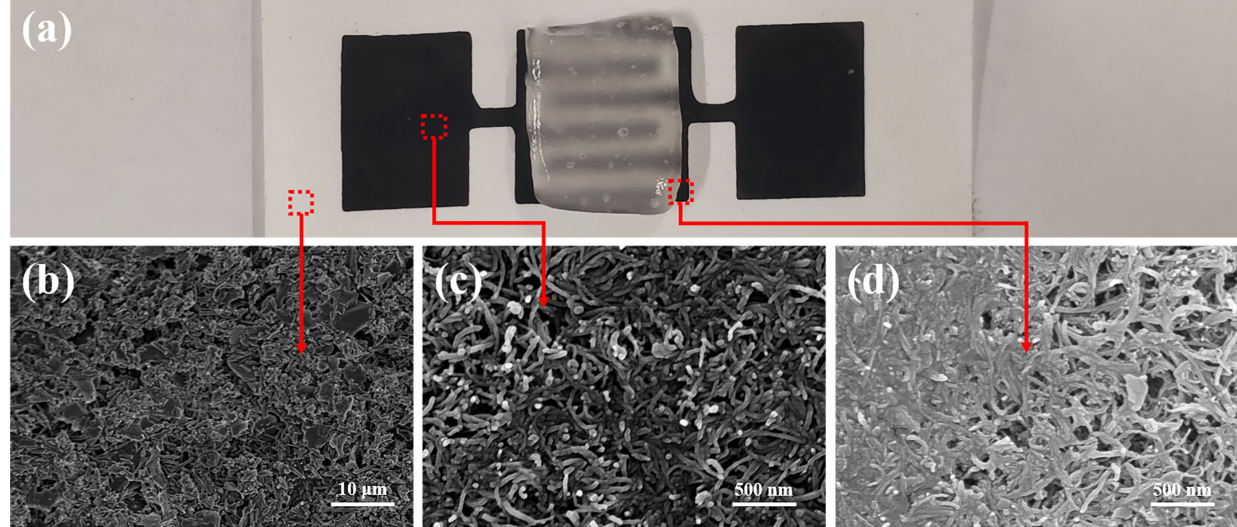
Figure 6. ( a ) Digital photograph of the as-assembled MSCs. ( b ) The surface SEM image of cellulose paper substrate. ( c ) The surface SEM image of MWCNT interdigitated microelectrodes. ( d ) The surface SEM image of the interface between BPVA-Pluronic hydrogel electrolyte and MWCNT interdigitated